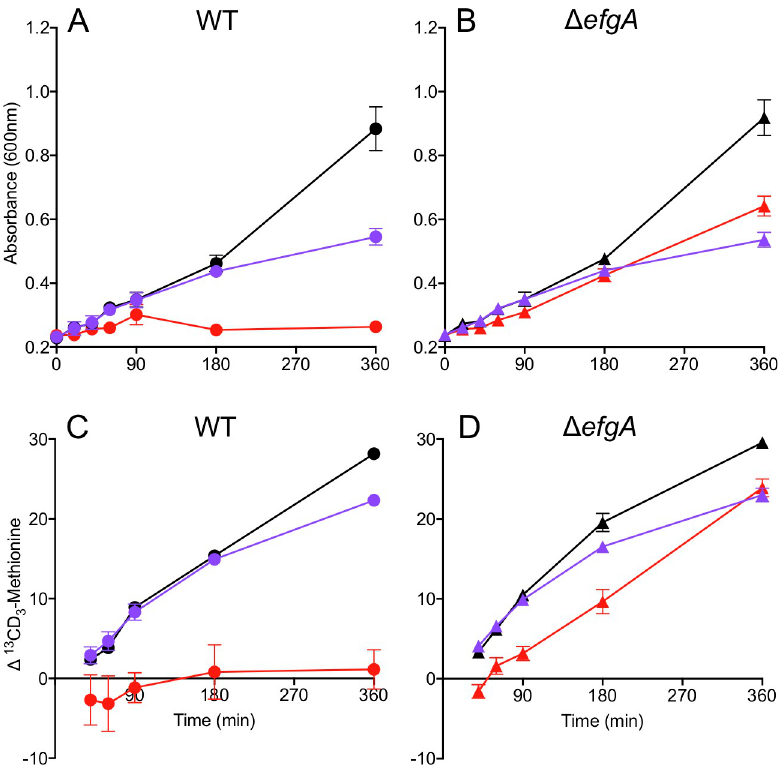
Fig 13. EfgA causes rapid growth arrest and cessation of translation in response to formaldehyde. Exponential phase cultures of wild-type (circles, A, C) and Δ efgA mutant (triangles, B, D) strains were treated with kanamycin (purple), exogenous formaldehyde (red) or left untreated (black). Top panel: Growth in response to treatment (t > 0 min) was monitored. Bottom panel: After treatment (t > 0 min) in vivo translation was assayed via [ 13 CD 3 ]- methionine incorporation. Error bars represent the standard error of the mean for three biological replicates. The original data shown in this and all other figures are available in Supporting information file S1 Data.